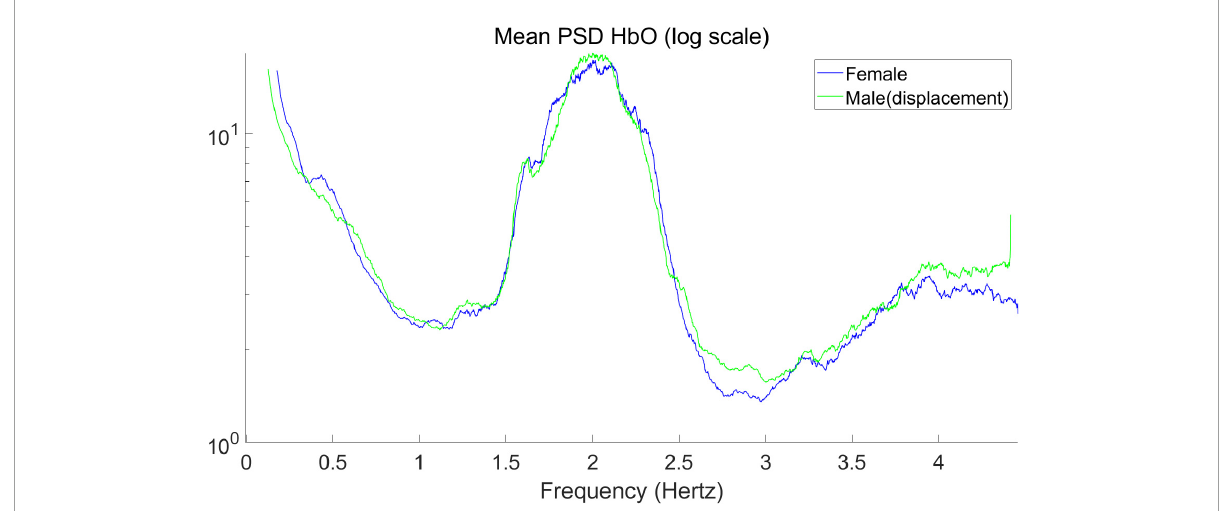
FIGURE4 Mean power spectral density of the average signal for HbO (after displacement in Figure 3 ).